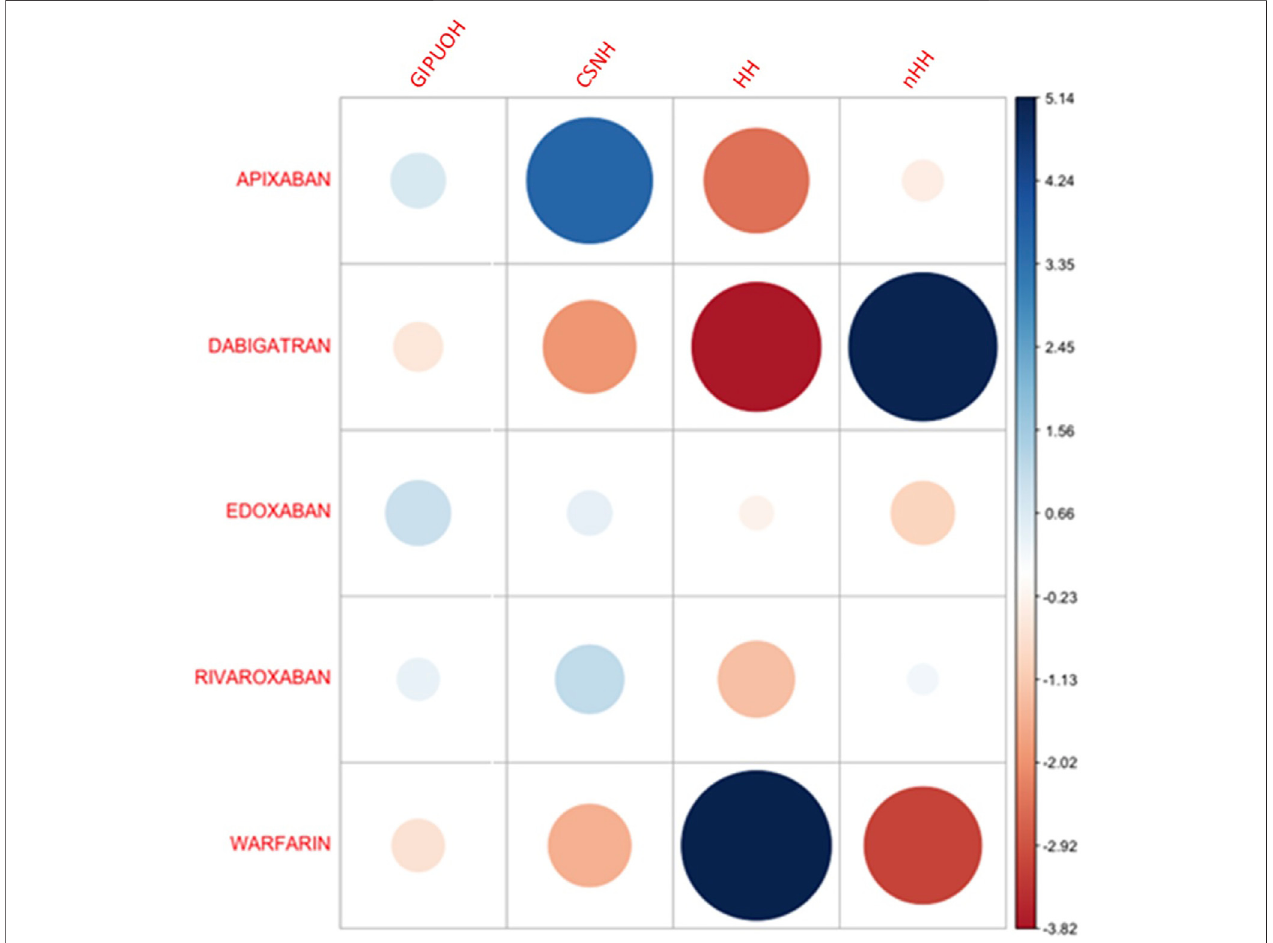
FIGURE3| Pearsonresiduals – Positiveresidualsareinblue,negativeresidualsareinred.Thesizeofthecircleisproportionaltotheamountofthecellcontribution.